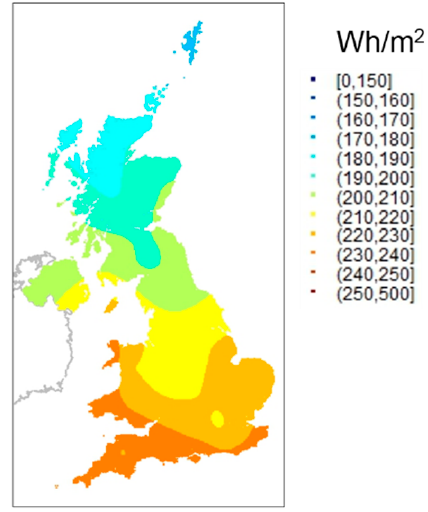
Figure 4. Average hourly global horizontal irradiation for 2013.